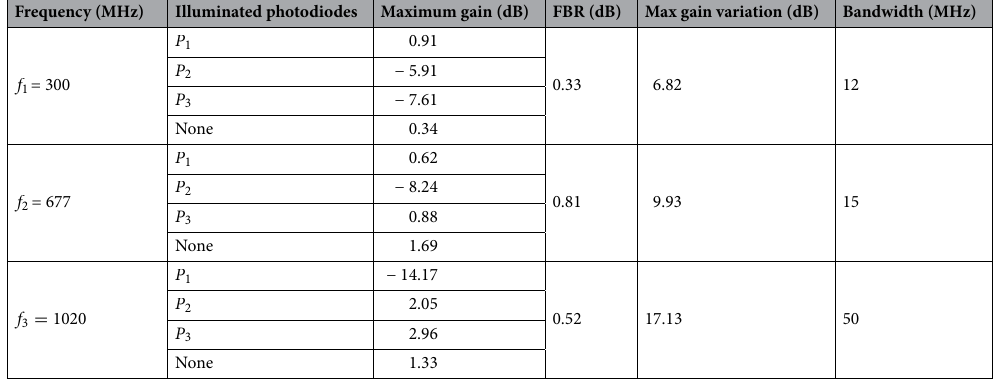
Table 5. Measured variation in radiation performance under different illumination condition.